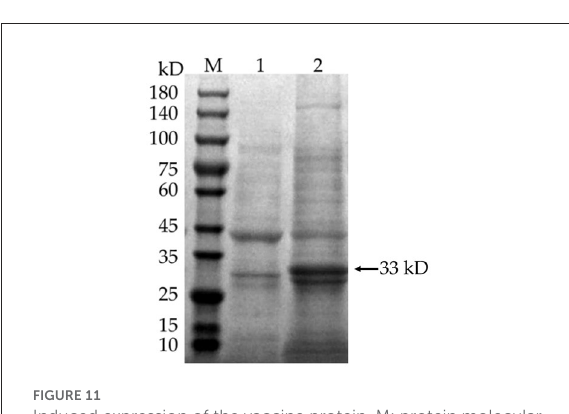
FIGURE11 Induced expression of the vaccine protein. M: protein molecular quality standard (10–180 kD); 1: pET-28a( + )-MEV recombinant bacteria, uninduced; 2: pET-28a( + )-MEV recombinant bacteria, induced. Full-length gels are presented in Supplementary Image